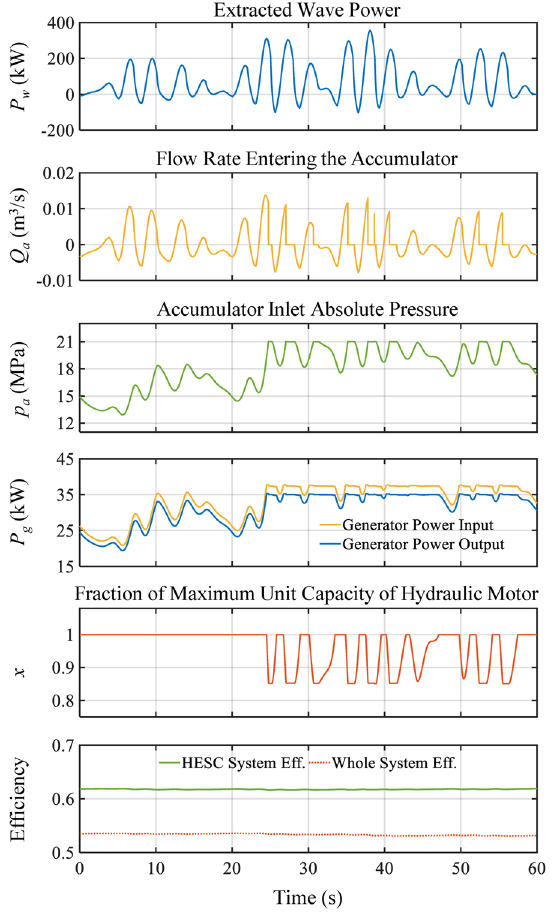
Fig. 5 HESC system operation performance at sea state 3